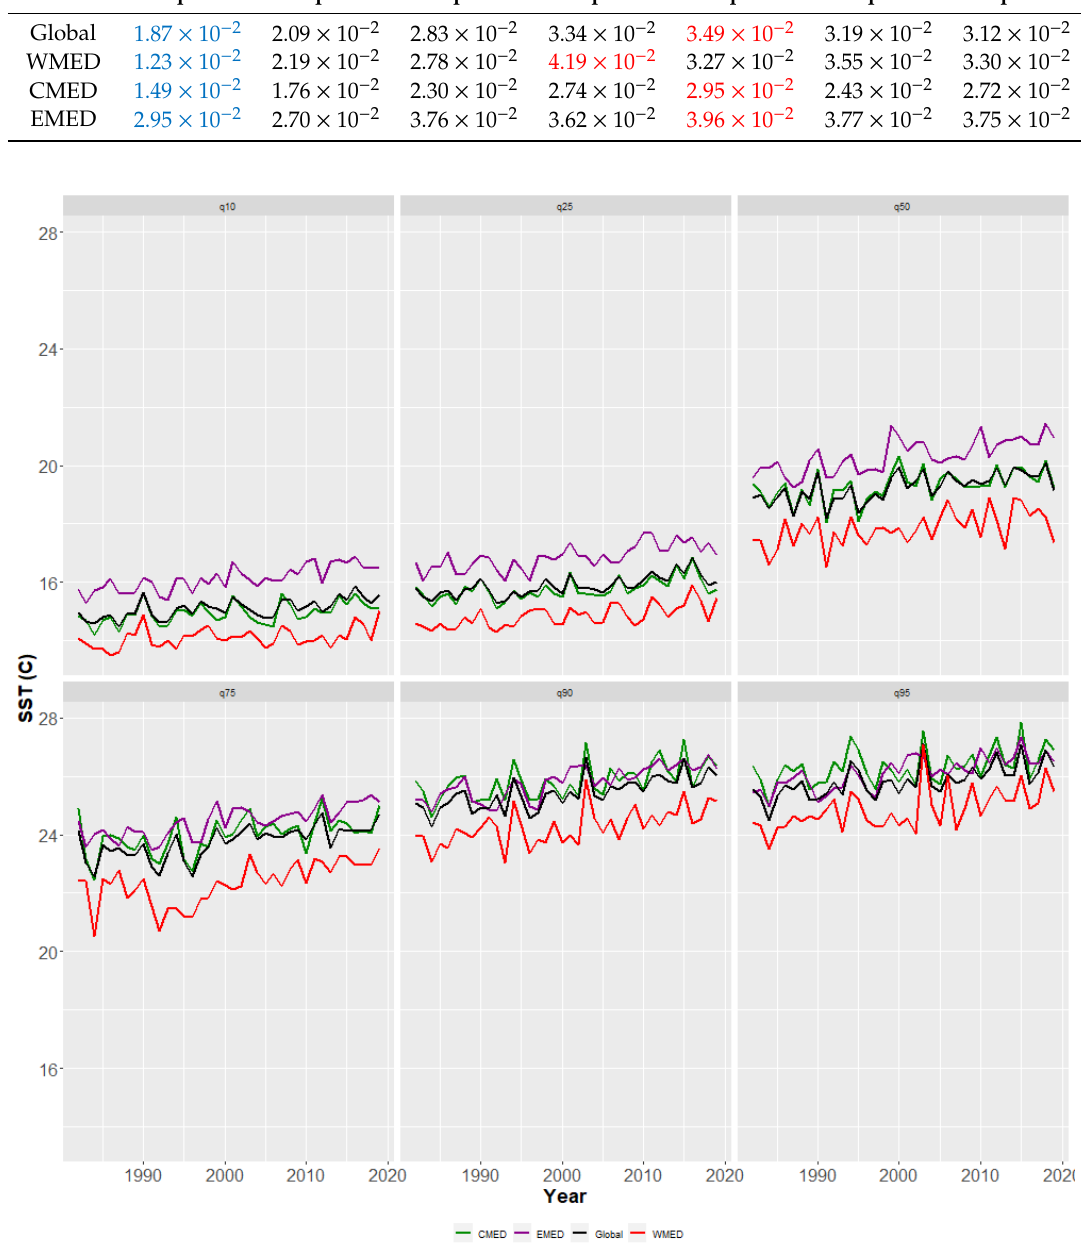
Figure 6. Deseasonalized SST percentile annual time series for the period 1982–2019 in the global Mediterranean basin (black), WMED (red), CMED (green) and EMED (magenta).